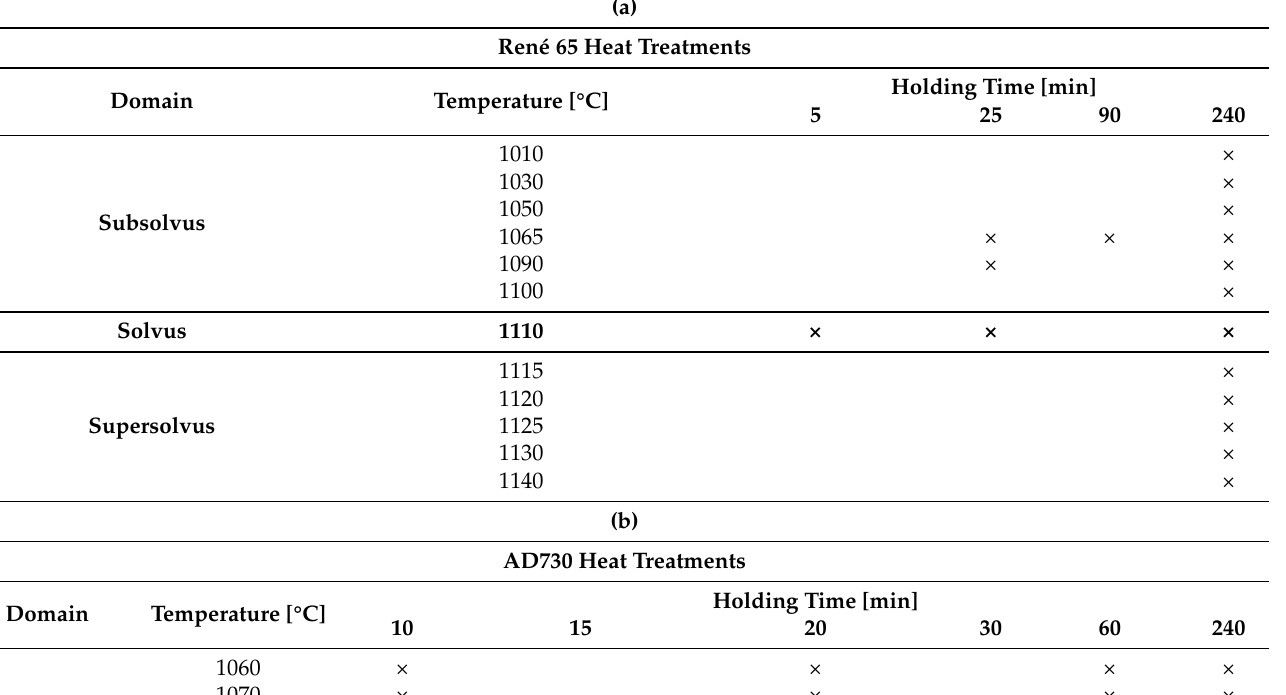
Table 2. Heat treatments done for each superalloy ( a ) René 65; ( b ) AD 730 and ( c ) N 19. (a) René 65 Heat